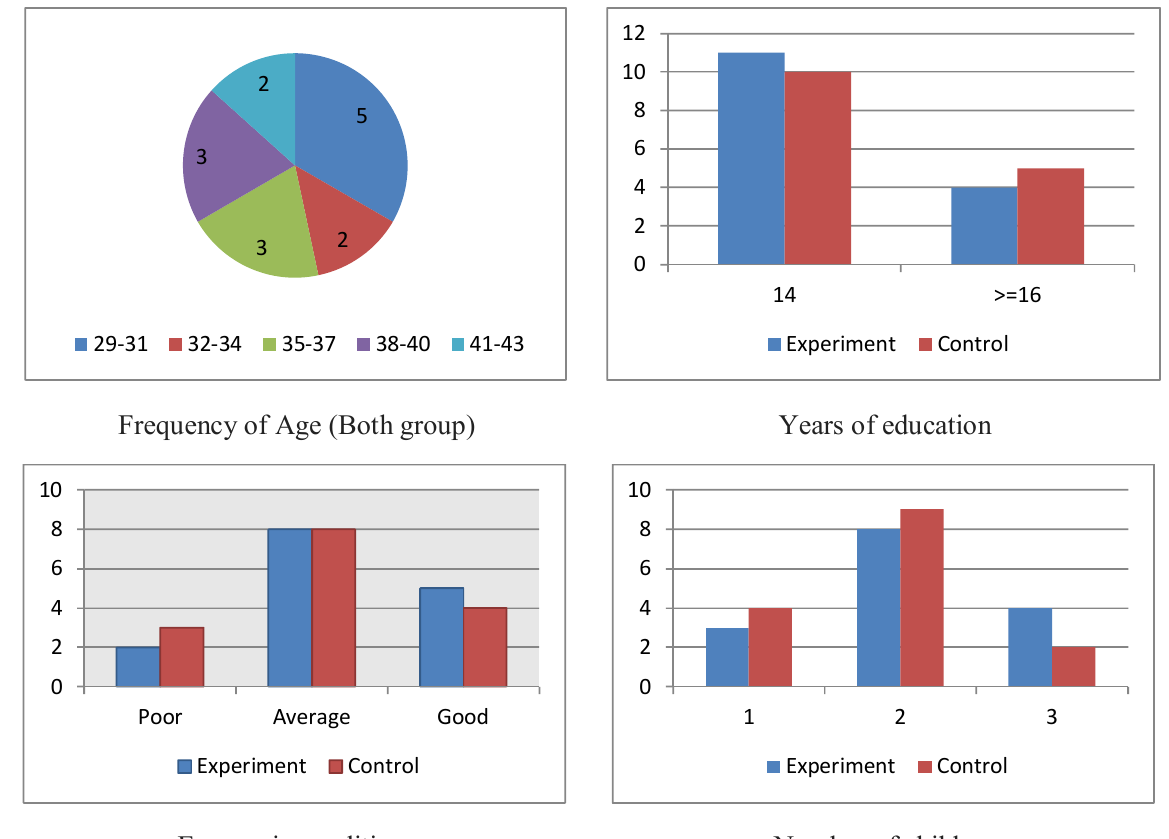
Fig. 1. Personal characteristics of the participants